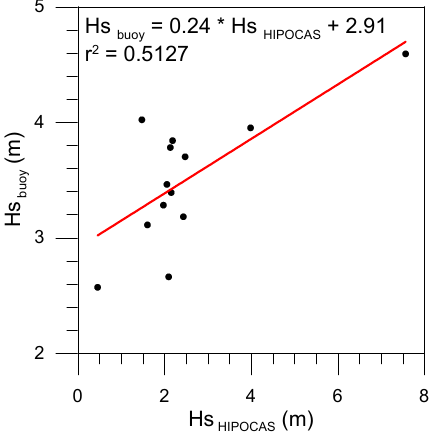
Fig. 3. Comparison of recorded and simulated significant wave height ( H s ) at the peak of the annual maximum storm for sector III of the Catalan Coast (see location in Fig.